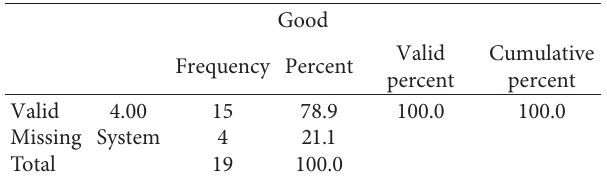
Figure 4: Lung CT images of COVID-19 findings before and after the process. The findings are in (red frame). Table 2: The scale results illustrate a good assessment of the images view improvement by radiologists.